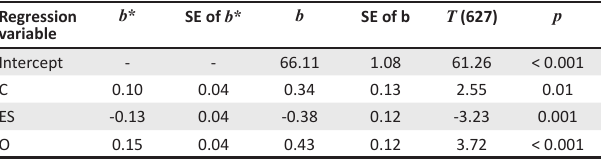
FIGURE 3: Normal probability plot of the residuals. TABLE 3: Regression summary for overall academic performance as dependent variable ( n =